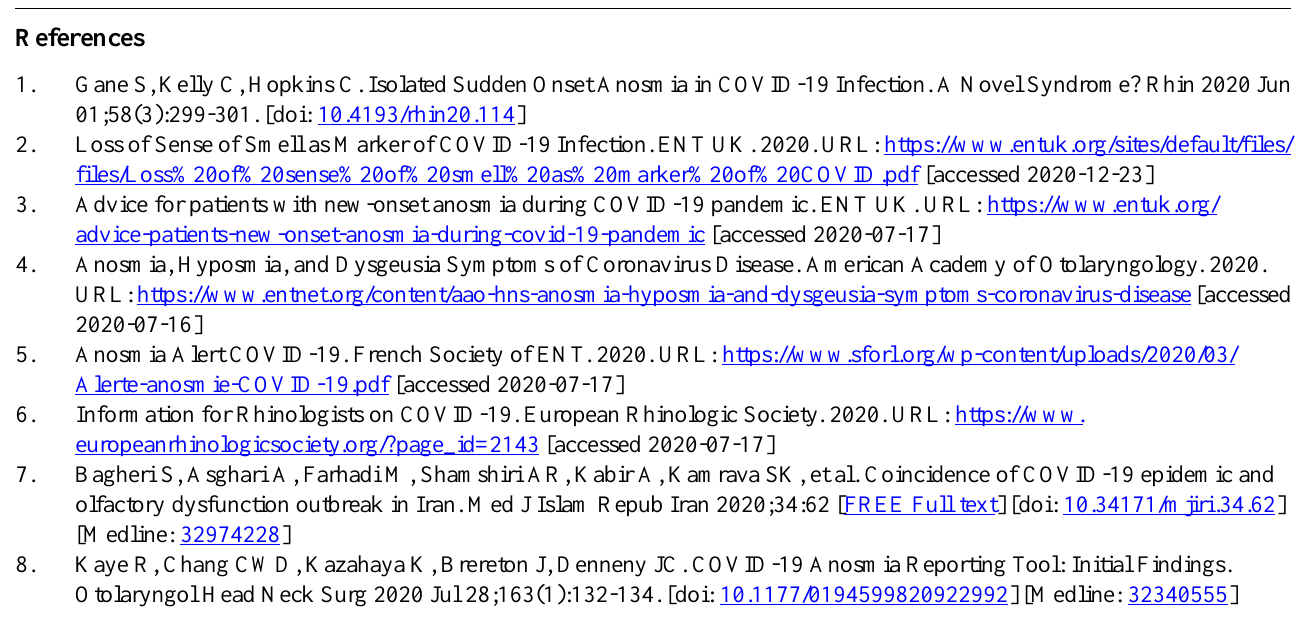
Table S2. Questionnaire items and their